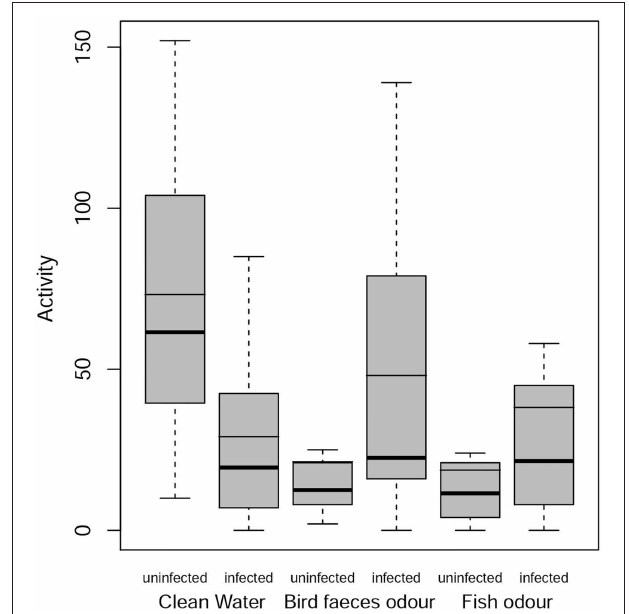
FIGURE 2 | Activity levels of infected and uninfected G. insensibilis . Activity levels (number of times that it left a compartment) as a function of gammarid infection status (uninfected or infected with M. papillorobustus ) and water condition (control or the presence of fish [non-host] or bird [definitive host] predator odors). Boxes extend from the 1st to the 3rd quartiles, whiskers extend from the boxes 1.5 times the interquartile range, dots represent extreme data, bold lines inside the boxes correspond to the median, slim lines to the mean. Notice that in the third box, the mean is equal to the third